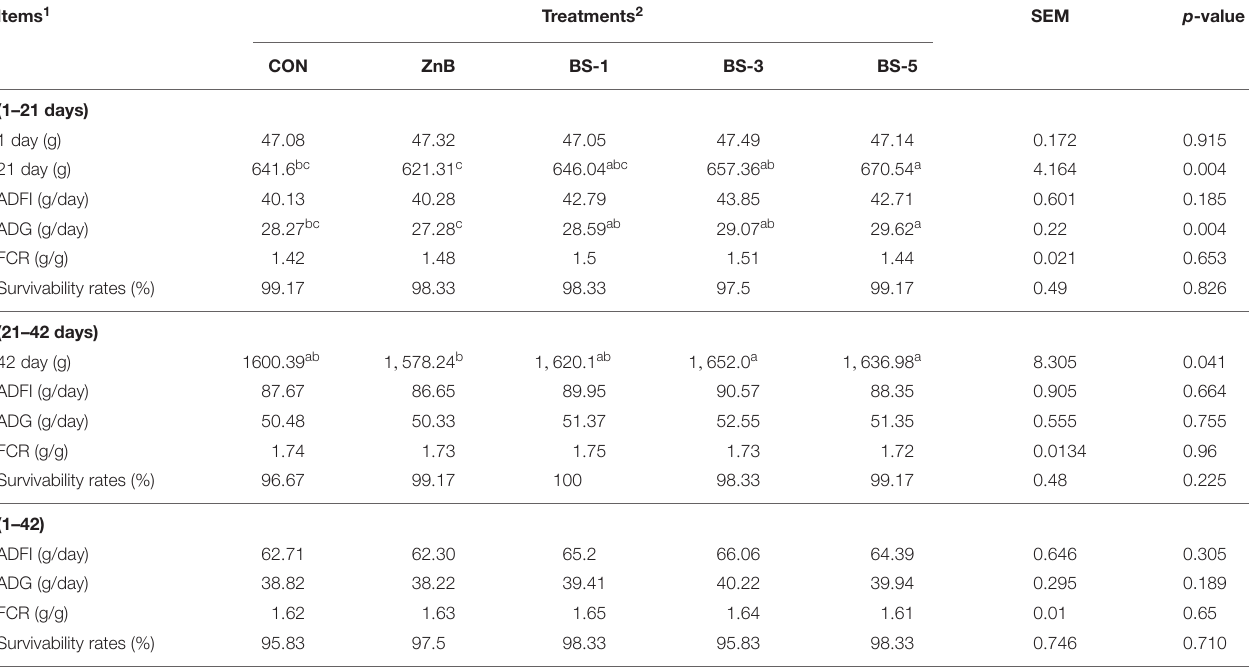
TABLE 2 | Effect of dietary supplementation of Bacillus subtilis ATCC19659 on the broiler’s growth performance. Items 1 Treatments 2